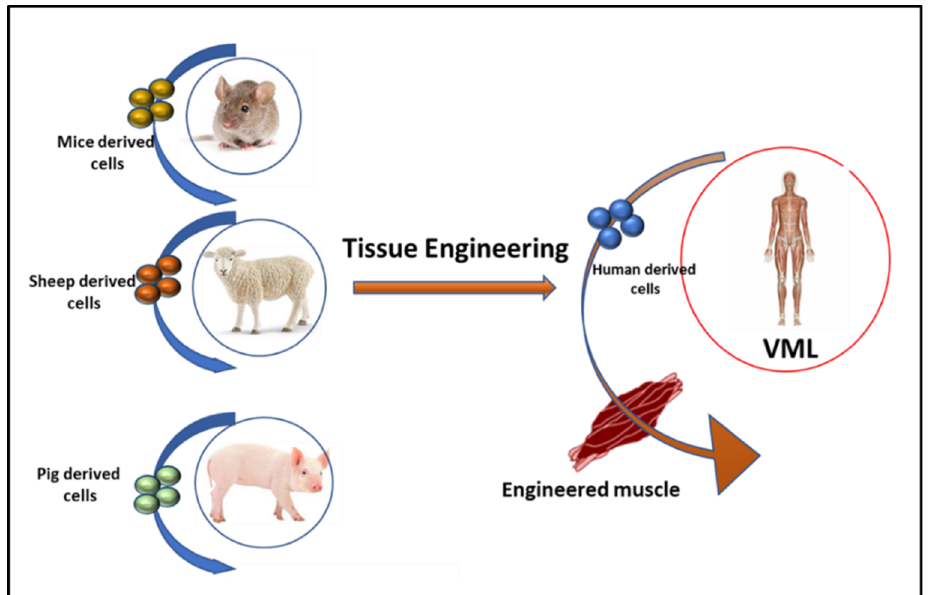
Figure 3. Tissue engineering for VML : Tissue engineering techniques help to repair damaged or completely lost muscle in small (lab animals) and large animals including sheep and pigs by the combination of cells, growth factors, and biomaterial scaffolds. The engineered muscle is then transplanted in VML patients.